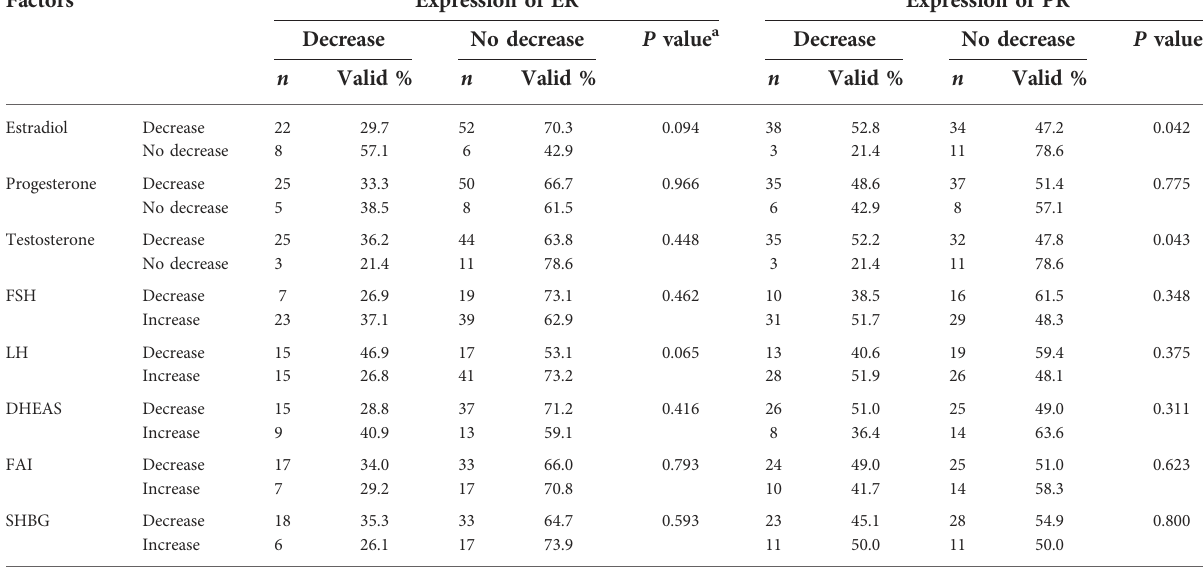
TABLE 4 Analysis of reproductive hormone changes associated with alterations of hormone receptors expression in patients with hormone receptors positive.